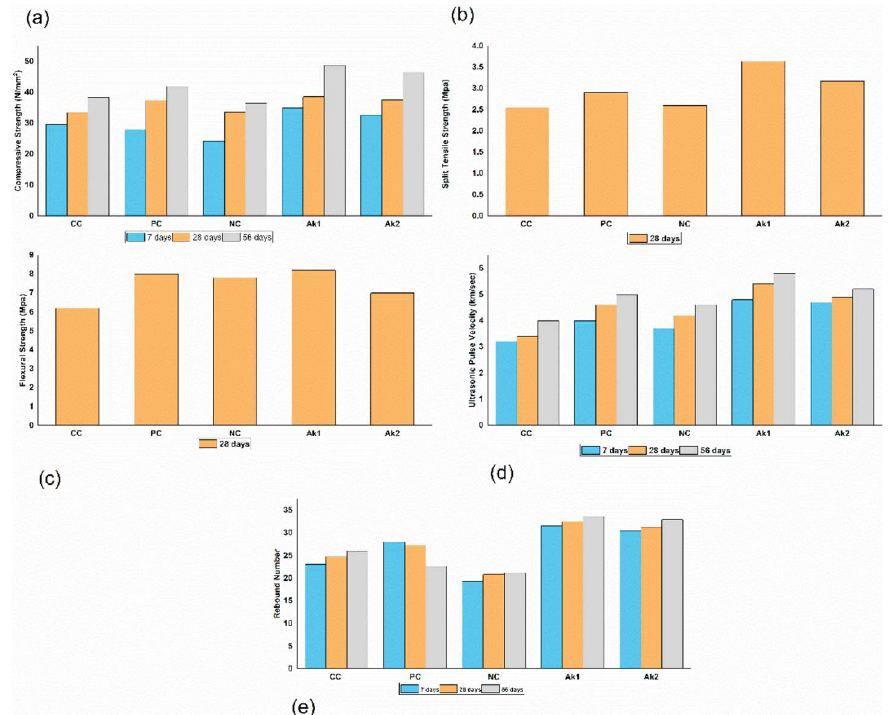
Figure 3. (a) Bacterial growth characteristics compressive strength results at 7, 28 and 56 days. (b) Split tensile strength 28 days. (c) Flexural strength for 28 days. (d) Ultrasonic pulse velocity test results at 7, 28 and 56 days. (e) Rebound hammer test values for 7, 28 and 56 days